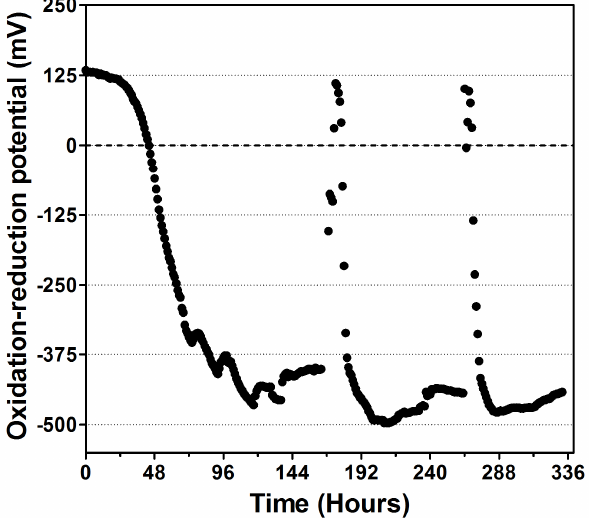
Figure 4. Time course of oxidation–redox potential of the immobilized Rhodopseudomonas sp. cells in calcium alginate beads, which were immersed in the cylindrical photobioreactor. The redox potential increased at 165 and 264 h which correspond to the presence of O 2 that entered in the system during the beads washing procedure.